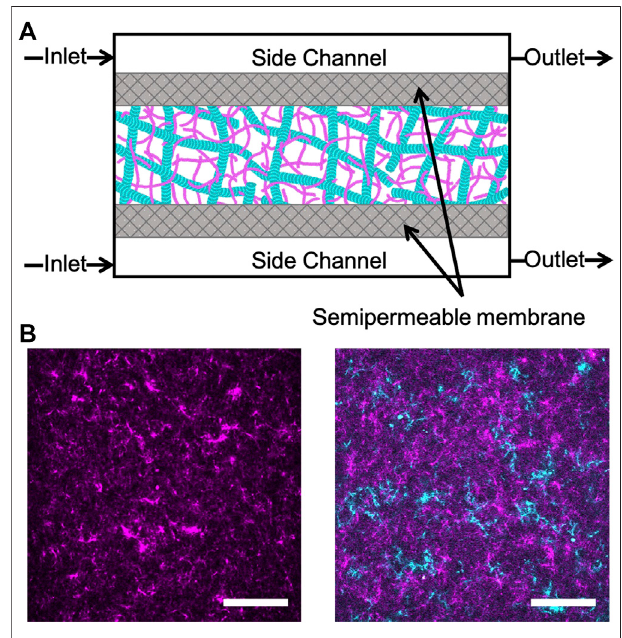
FIGURE 1 | Experimental approach to triggering cation-induced contraction of cytoskeleton networks. (A) Cartoon of micro fl uidic device comprised of three channels separated by two semipermeable membranes (gray). The device has a central chamber containing the sample and two sidechannelsusedforbufferexchange.Bufferispulledintotheinletandoutof the outlet throughcapillary tubing using asyringe pump. The fl ow rateisset to allow for passive diffusion of buffer into the sample chamber as it fl ows from inlet to outlet. (B) Two-color laser scanning confocal images of an actin network (left) andanequimolaractin-microtubulenetwork (right) whereactin is magenta and microtubules are cyan. Scale bar is 50 μ